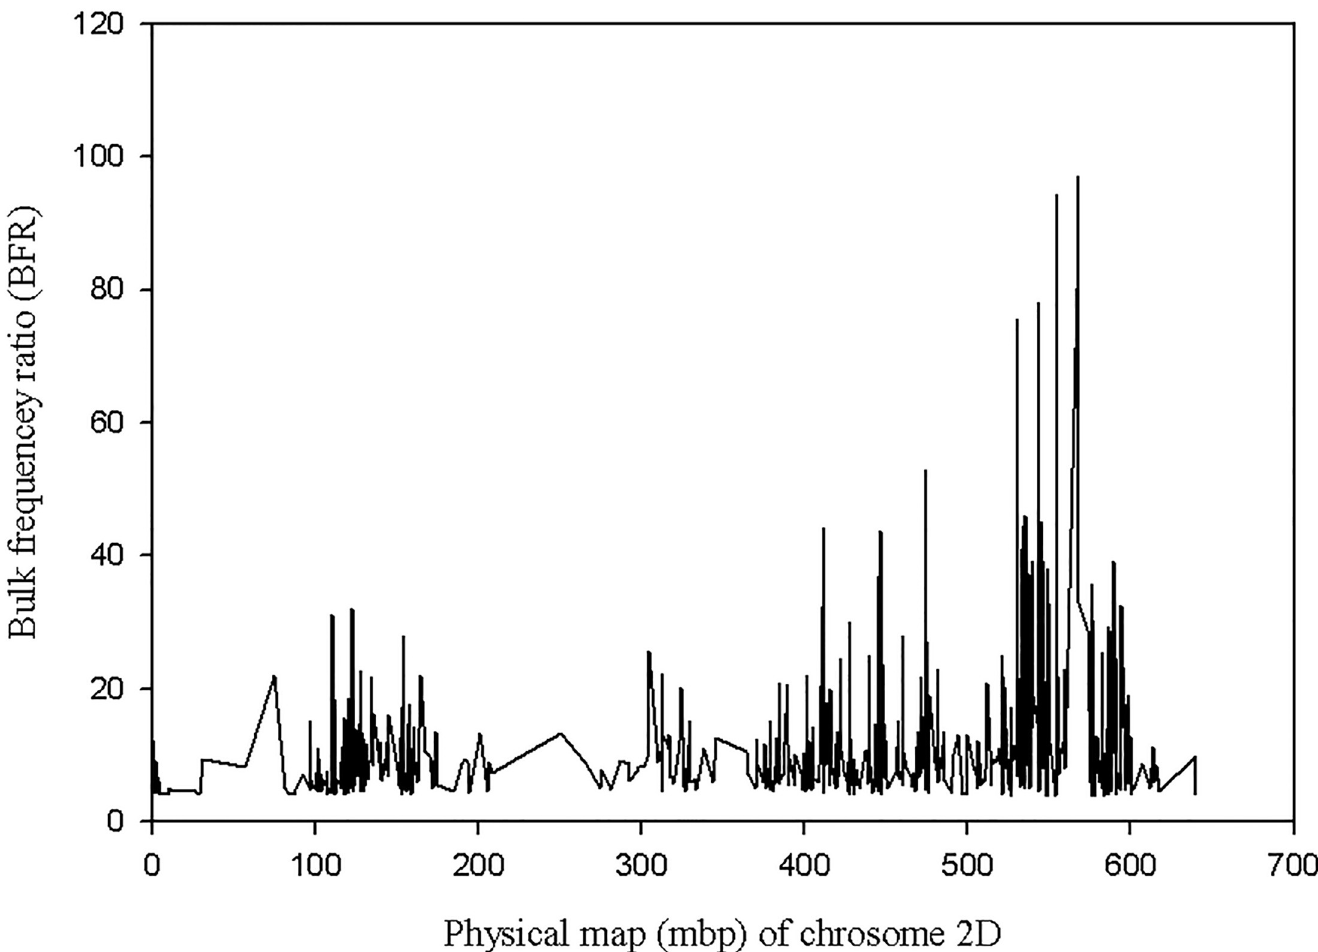
Fig 6. Distribution of SNPs with bulk frequency ratio higher than 4 on chromosome 2D Ae . tauschii chromosome.